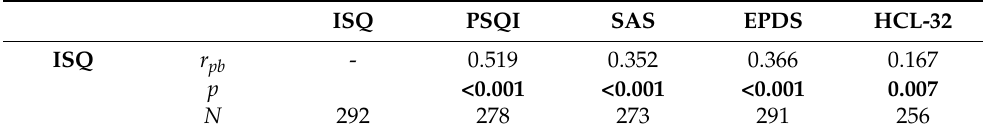
Table 3. Correlations matrix between the ISQ (T0) total score and other scales (T0).